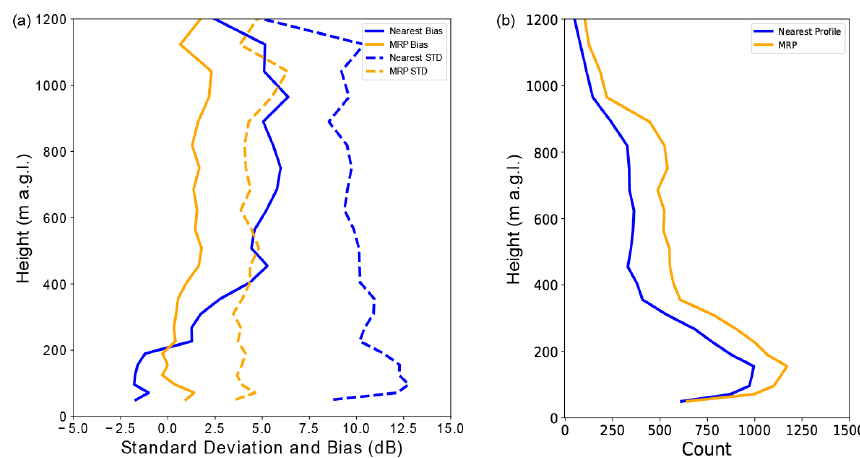
Figure 10. (a) The bias and standard deviation of observation–simulated radar reflectivity at SIRTA for the period 1 November 2018– 19 February 2019. The statistics were calculated for instances when reflectivity was both observed and simulated at a given range gate at a given time. (b) The count of cells for which reflectivity was observed and simulated.